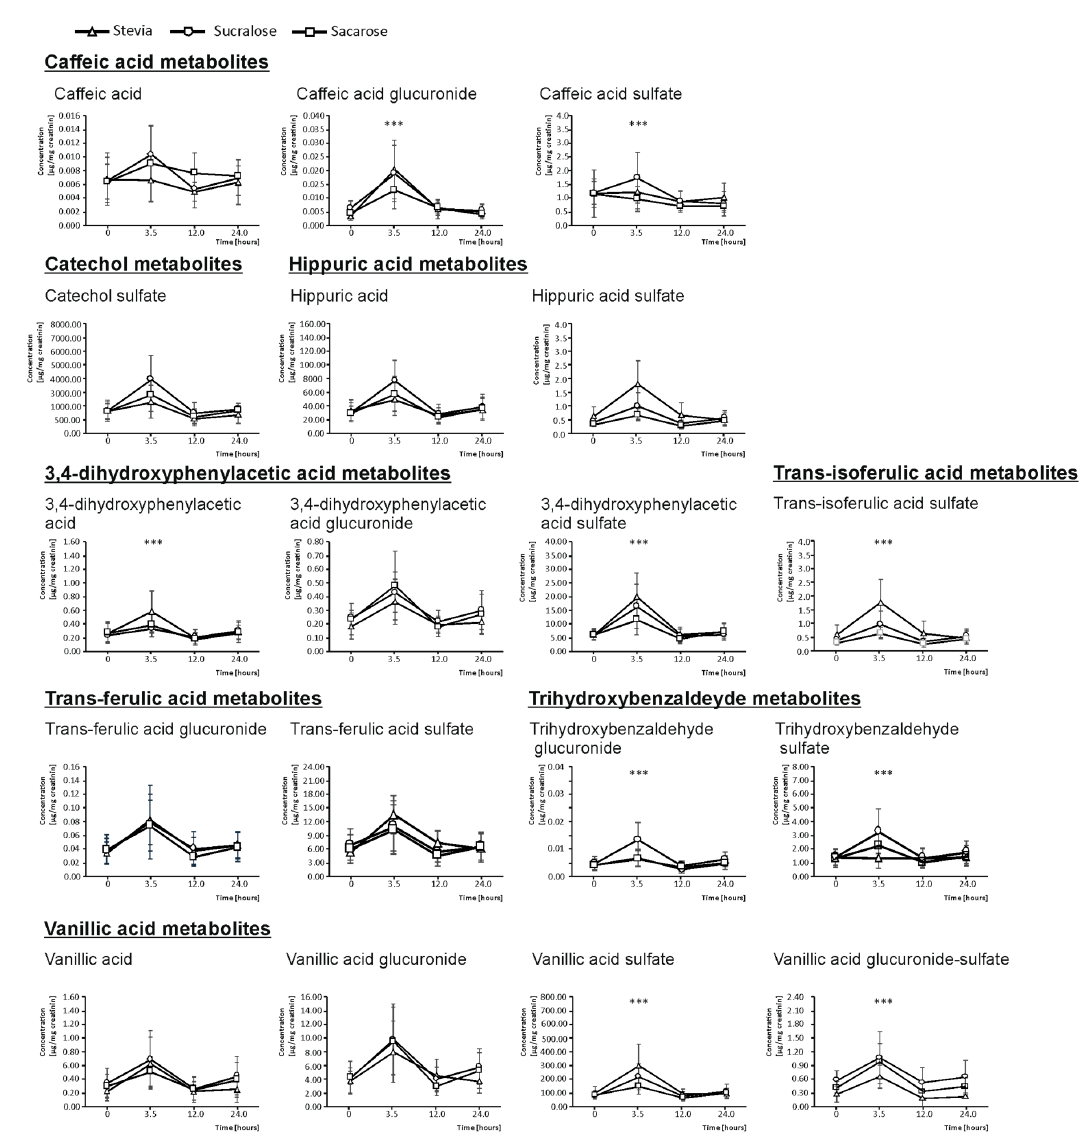
Figure 1. Content (mean ± SD, n = 20 ) of single anthocyanins metabolites (caffeic acid, caffeic acid-glucuronide, caffeic acid-sulfate, catechol-sulfate, 3,4-dihydroxyphenylacetic acid, 3,4-dihydroxyphenylacetic acid-glucuronide, 3,4-dihydroxyphenylacetic acid-sulfate, hippuric acid, hippuric acid-sulfate, trans -ferulic acid-glucuronide, trans -ferulic acid-sulfate, 3,4-dihydroxyphenylacetic acid -glucuronide, 3,4-dihydroxyphenylacetic acid-sulfate, trans -isoferulic acid-sulfate, vanillic acid, vanillic acid-glucuronide, vanillic acid-glucuronide-sulfate, and vanillic acid-sulfate) in basal urine and 3.5,12, and 24-h urine of healthy volunteers after ingesting 330 mL of maqui-citrus juices developed using as sweeteners stevia ( ∆ ), sucralose (O), and sucrose ( □ ). Signi fi cantly di ff erent bioavailabilities according to an analysis of variance (ANOVA) and duncan’s multiple rank test were found at p < 0.001 (***).